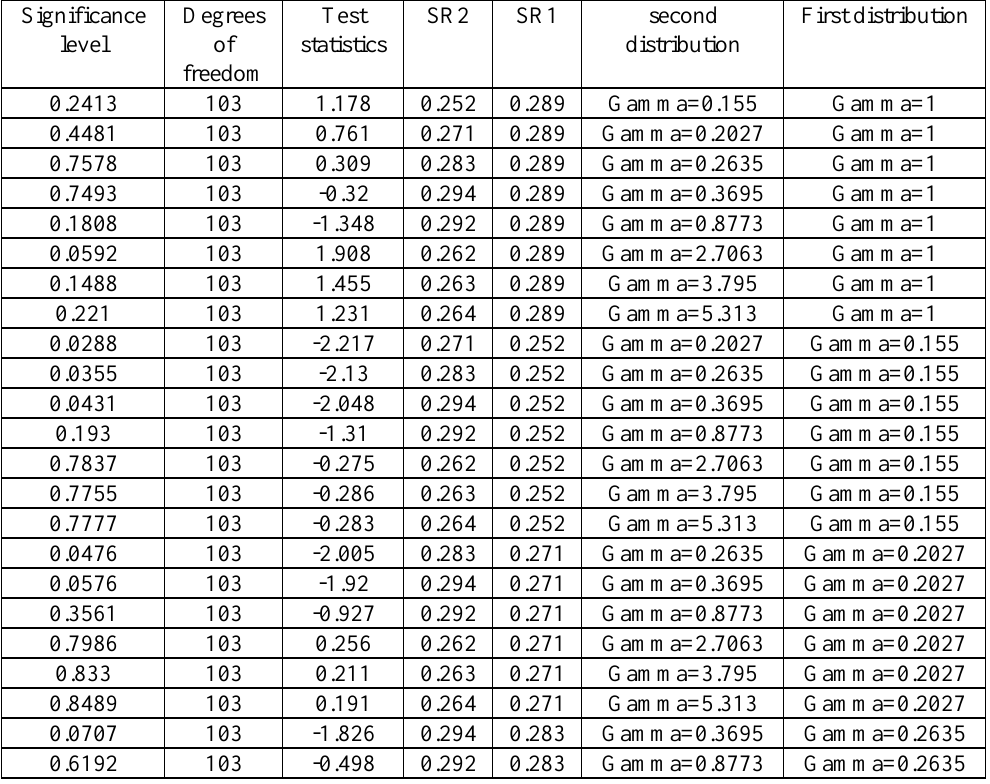
Table 2. Sharp Ratio Equality Test to Compare Portfolio Performance (Research